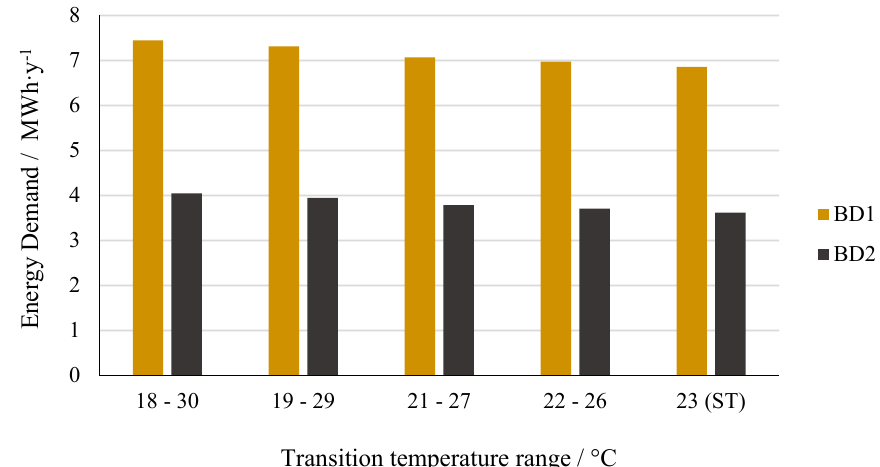
Figure 6. Annual final energy demand, for building configurations BD1 and BD2 located in Madrid, Spain, considering different transition temperature ranges.